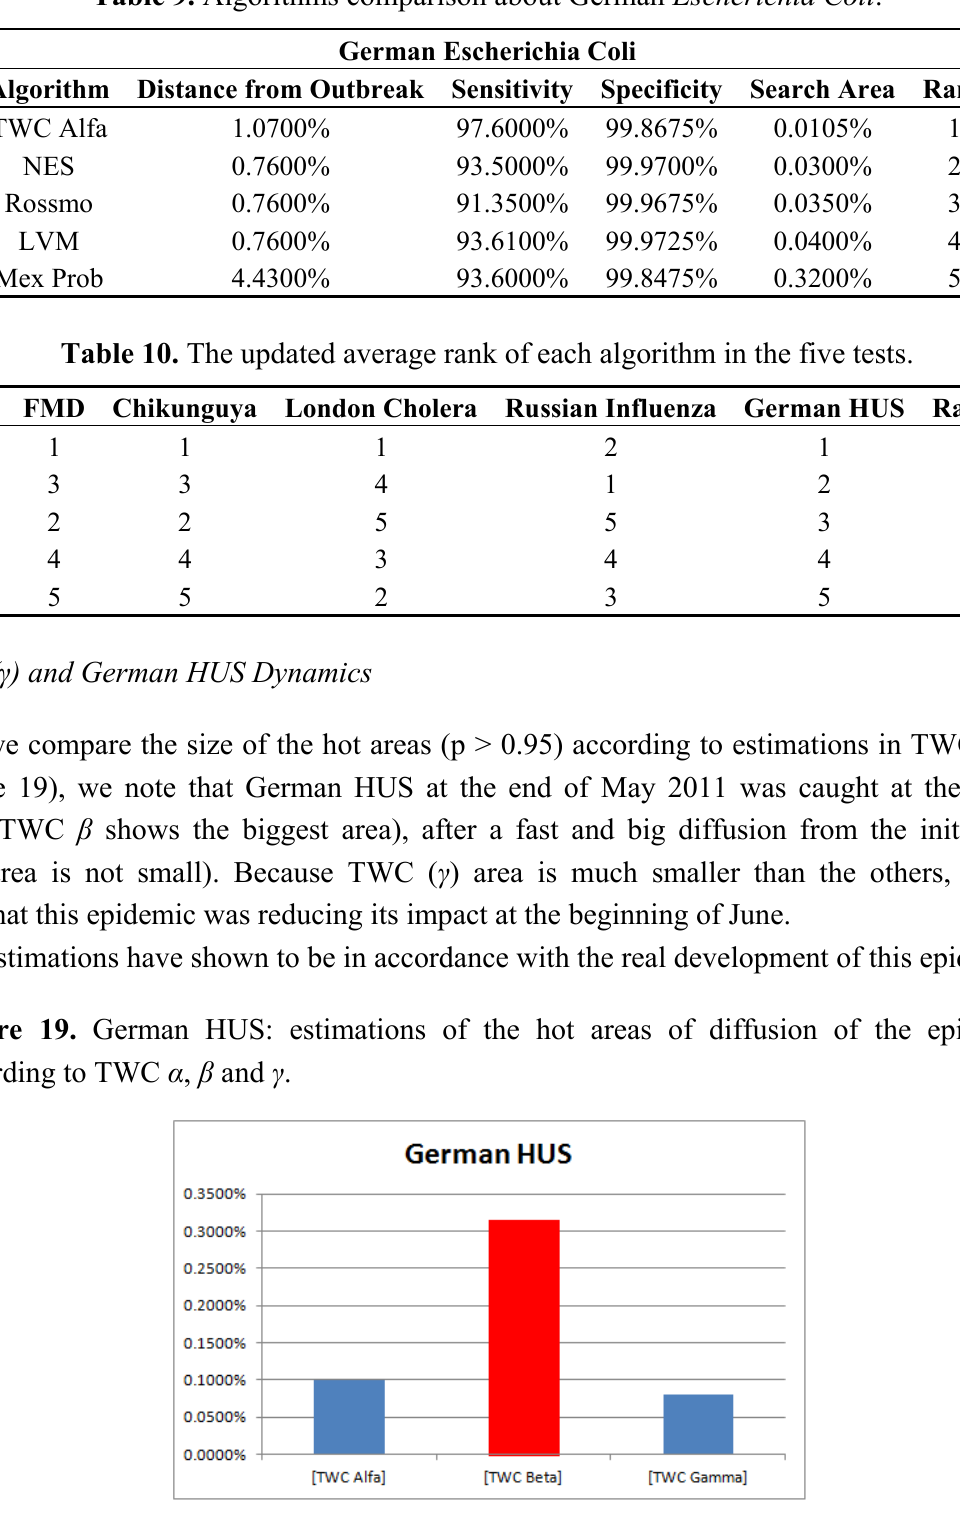
Table 9. Algorithms comparison about German Escherichia Coli .